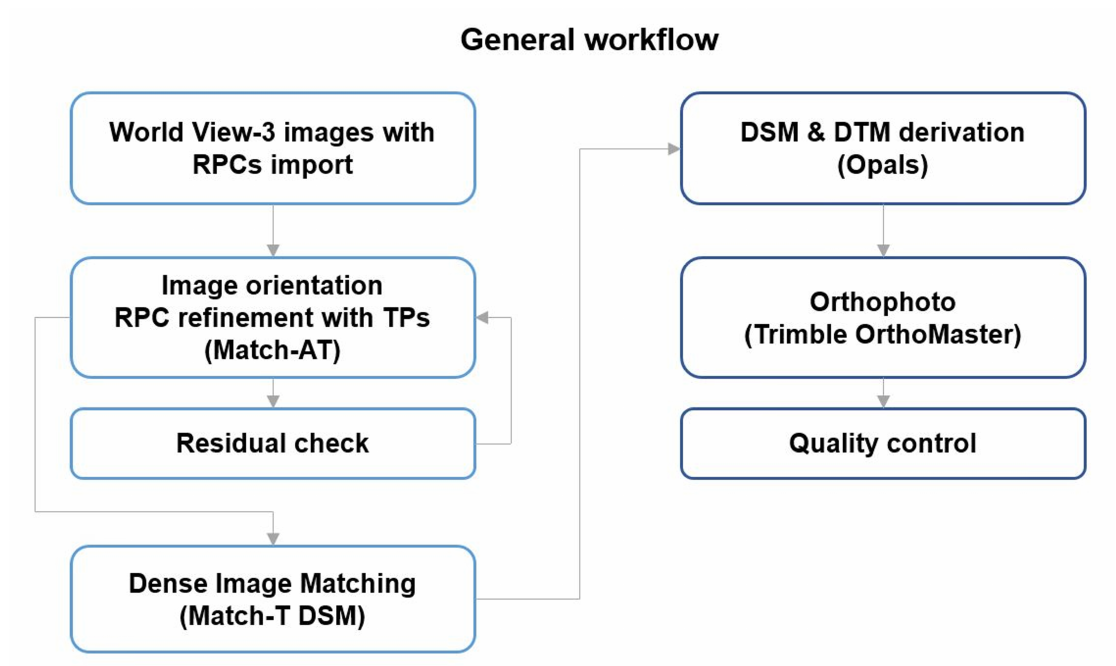
Figure A1. The general workflow for satellite image processing, 3D reconstruction, DSM, digital terrain model (DTM), and orthophoto derivation.